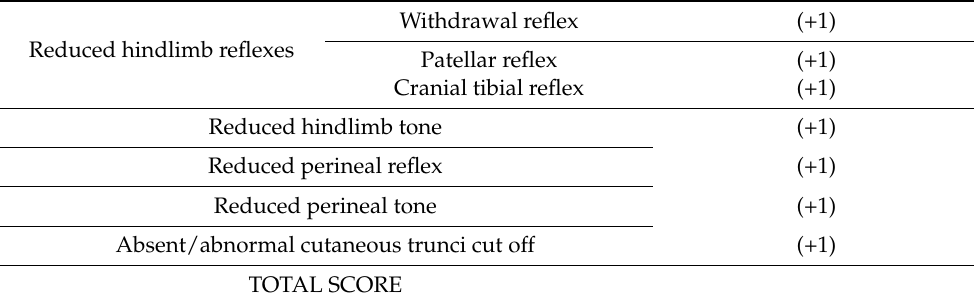
Table 2. Spinal Shock Scale